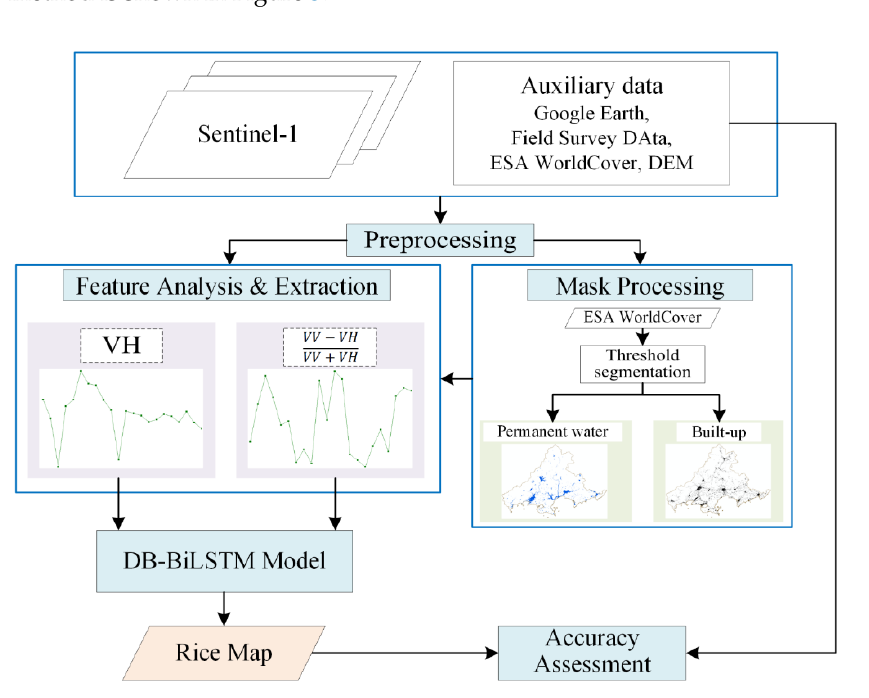
Figure 3. Flow chart of the proposed method.